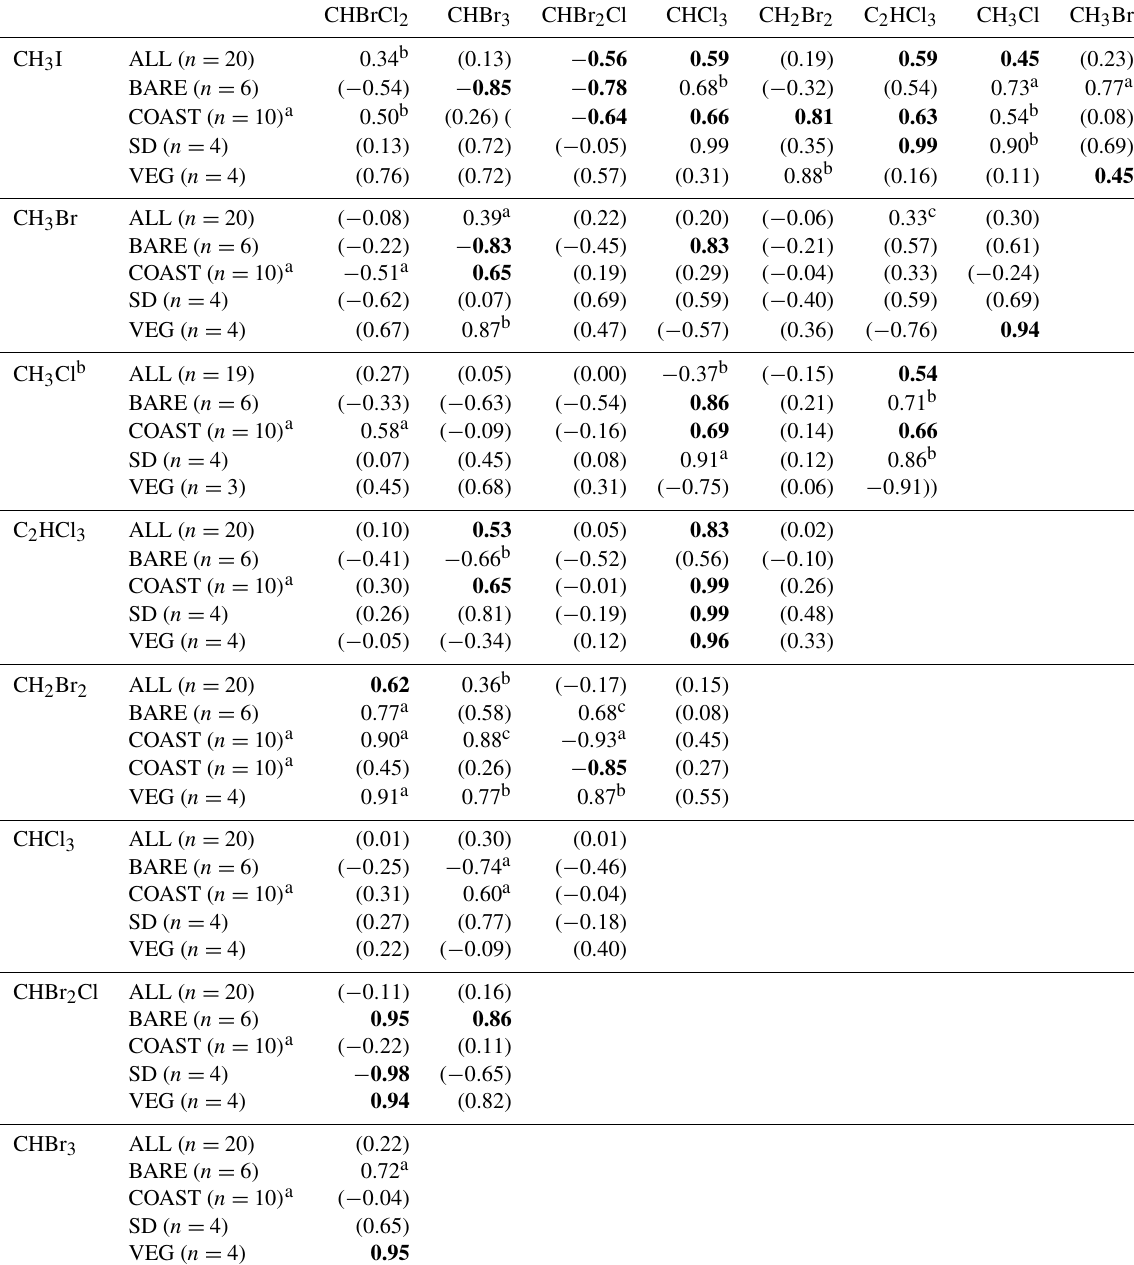
Table 5. Correlations between the measured net fluxes of VHOCs. The table records the Pearson correlation coefficient ( r ) for the measured net flux between each VHOC pair, calculated over all sites except SEA–KDM (ALL), bare soil sites (BARE), coastal sites (COAST), short distance from the sea at the coastal sites (SD) and the vegetated sites (VEG). The p value for r , being significantly different from zero, is indicated based on t test in four categories. By default, for bolded values, p <0.05. For values in parentheses, p >0.15. a p <0.1. b p